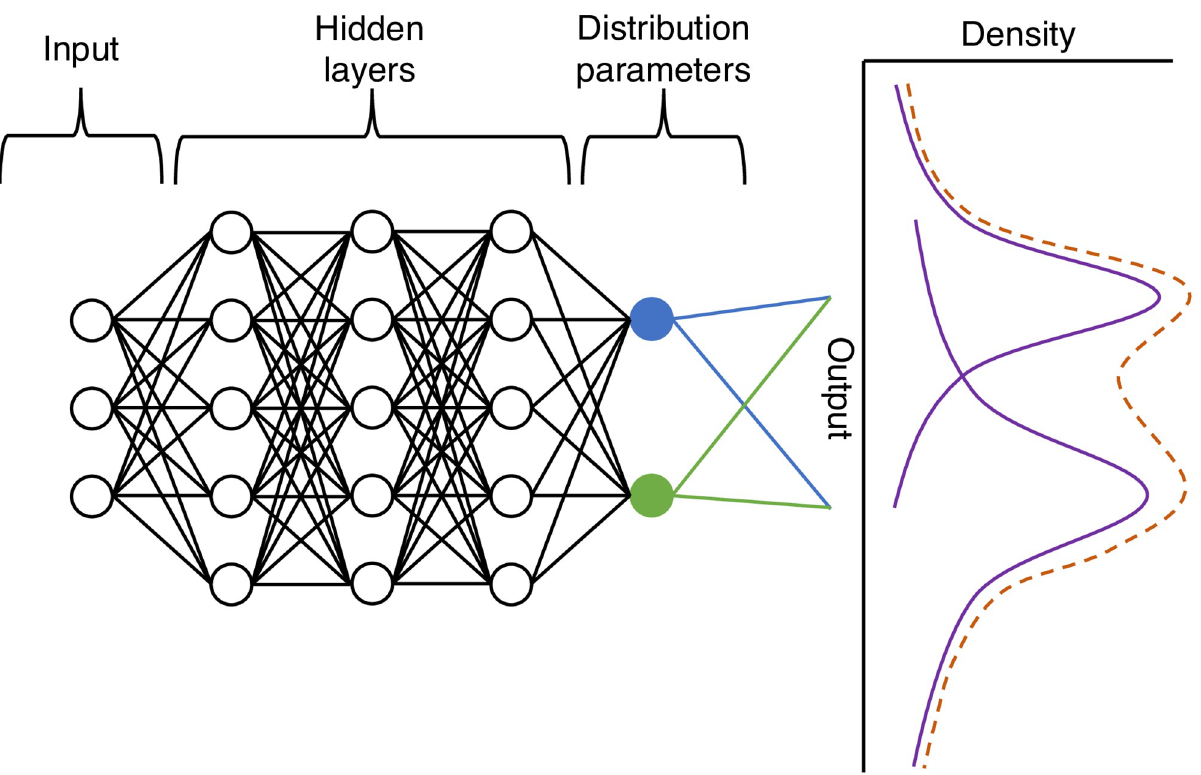
Fig 1. MDN that emulates a model with three inputs and a one-dimensional output with two mixtures. The inputs are passed through two hidden layers, which are then passed on to the normalised neurons, which represent the parameters of a distribution and its weights e.g. the mean (shown in blue) and variance (shown in green) of a normal distribution. These parameters are used to construct a mixture of distributions (represented as a dashed